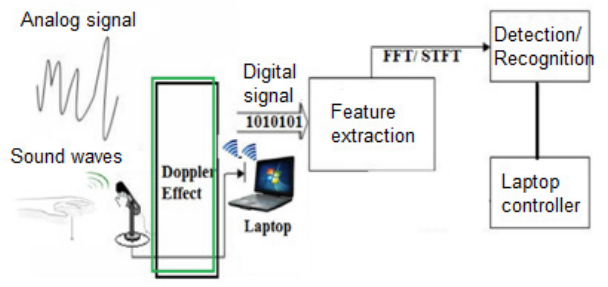
Figure 15. Our sound waves gesture recognition system for controlling applications on Laptop.